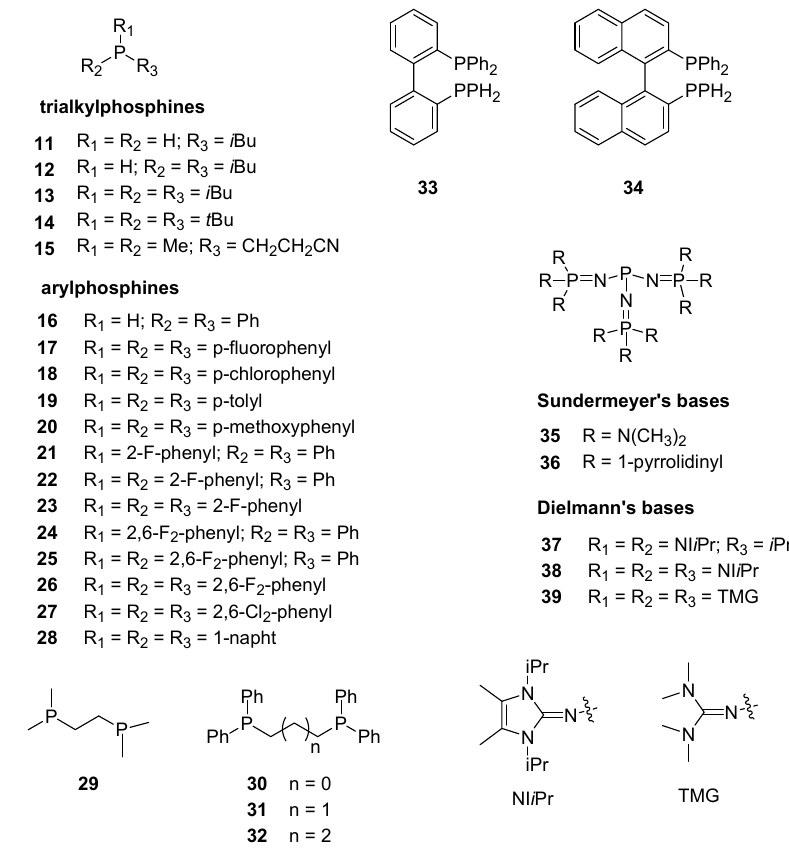
Scheme 2. Structures of phosphine bases with known p K a in acetonitrile.